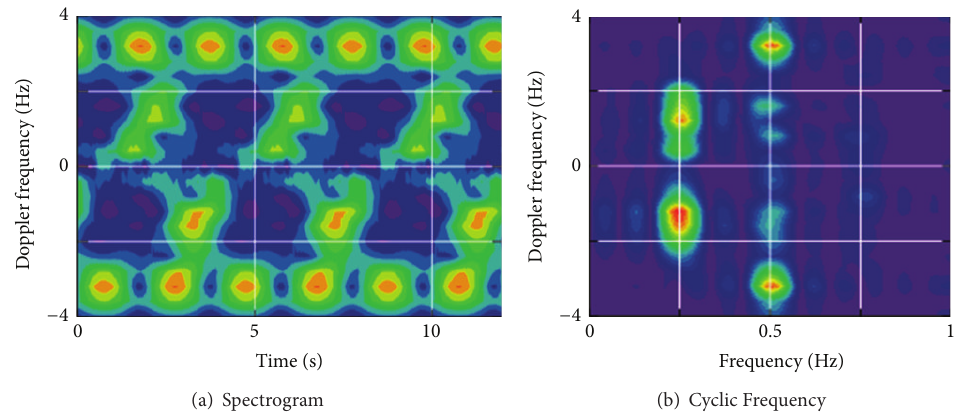
Figure 1: Cyclic Frequency method, the proposed data processing method.